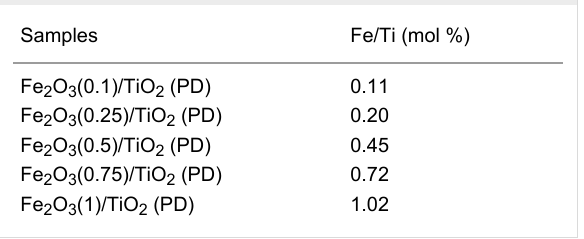
Table 2: The composition of the Fe 2 O 3 /TiO 2 (PD) nanocomposites (ratio of Fe/Ti (mol %)) determined from ICP-OES measurements. PD indicates samples that were prepared with the photodeposition method.